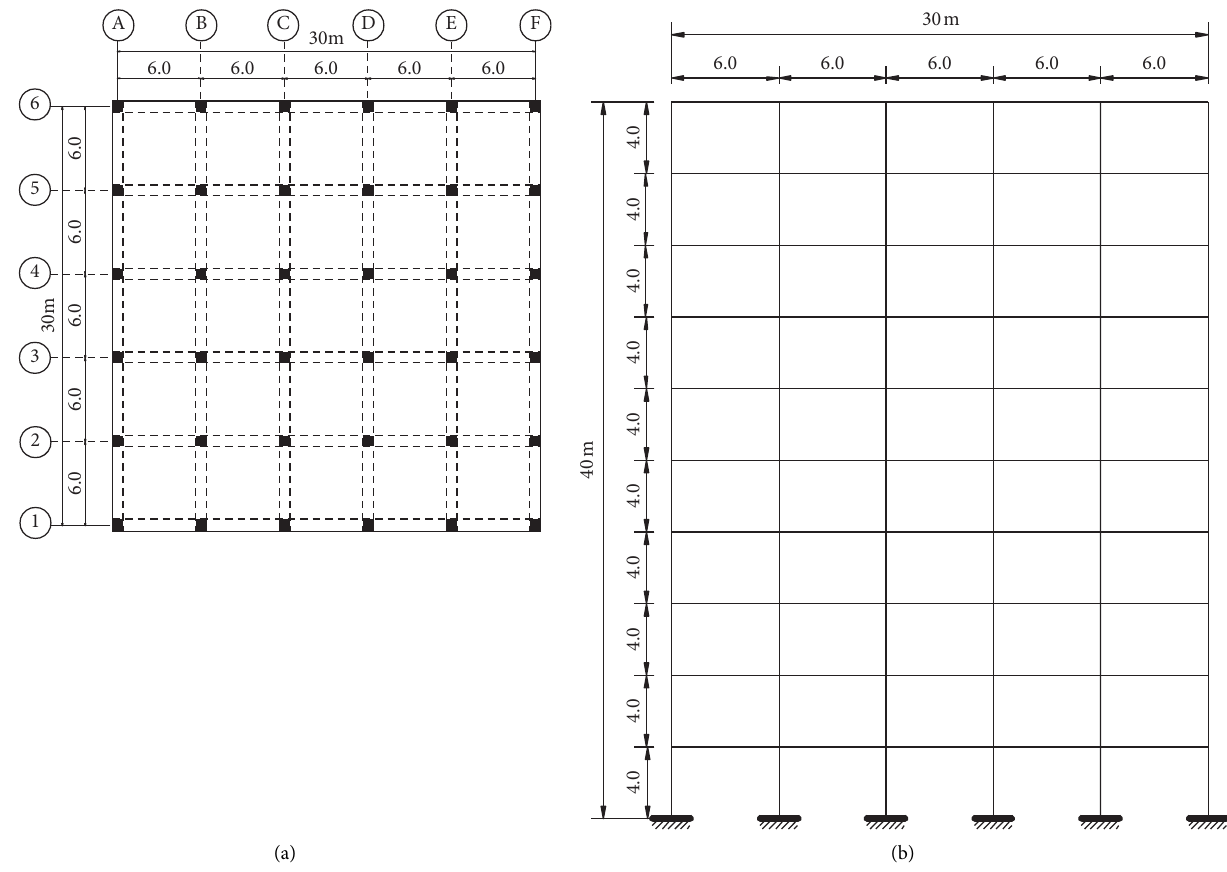
Figure 9: Geometric layout of the reinforced concrete frame structure. (a) Plan view. (b)